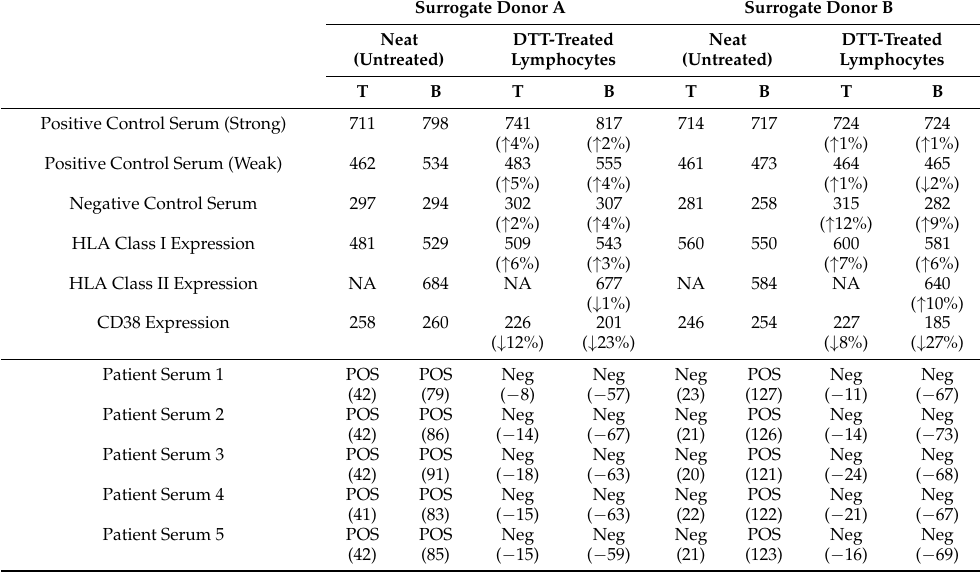
Table 1. Donor lymphocyte treatment by 0.05 M of DTT for 10 min at 37 °C effectively removed surface-bound CD38 and abrogated false-positive flow cytometric crossmatch (FCXM) outcomes caused by patient sera containing Daratumumab without affecting assay sensitivity and specificity. Values for the control sera and the HLA class I, HLA class II and CD38 expression are represented and analyzed in median channel fluorescence (MCF). Values for the five patient sera used in the surrogate donor crossmatches (in parentheses) are represented in median channel shift (MCS) from the negative control (i.e., patient serum MCF minus negative control MCF). Crossmatch outcomes were interpreted from MCS based on established positive cutoffs.